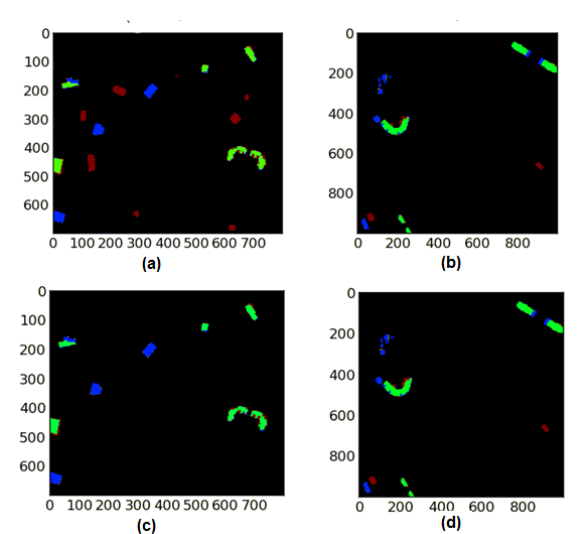
Figure 10. Change detection results, (a) and (b) are the region based change probability maps, (c) and (d) are the change detection results overlaid on the change reference mask (Green True positive; Red: False positive; Blue: False negative).